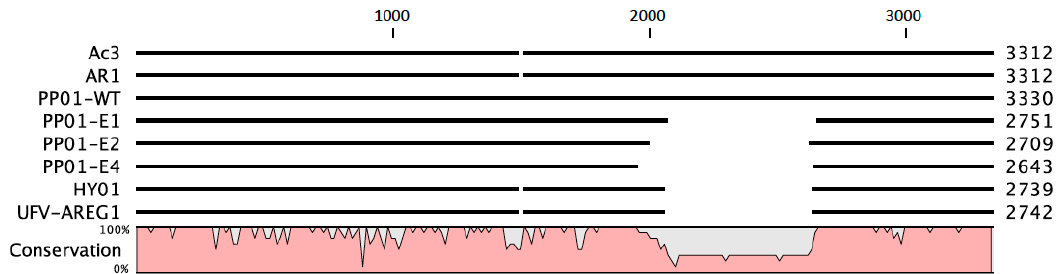
Figure 5. Nucleotide sequence alignments of closely related gp37 distal tail fiber genes from four coliphages sometimes reveal deletions similar to those observed in the current study. PP01-WT is the wildtype sequence, while PP01-E1, -E2 and -E4 are evolved sequences containing the deletions described in the Results section. Phages AR1, PP01, HY01 and UFV-AREG1 can infect E. coli O157:H7, whereas phage Ac3